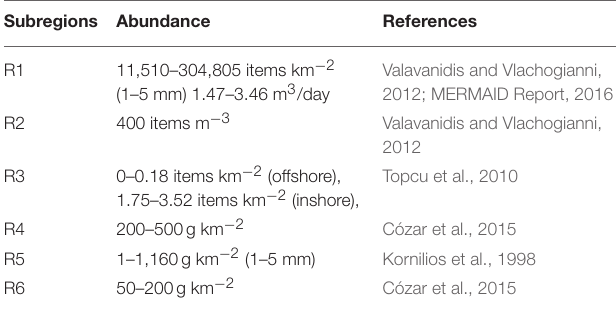
TABLE 2 | Measurements of floating litter abundance from different subregions (R1 to R6) in the Aegean Sea. Subregions